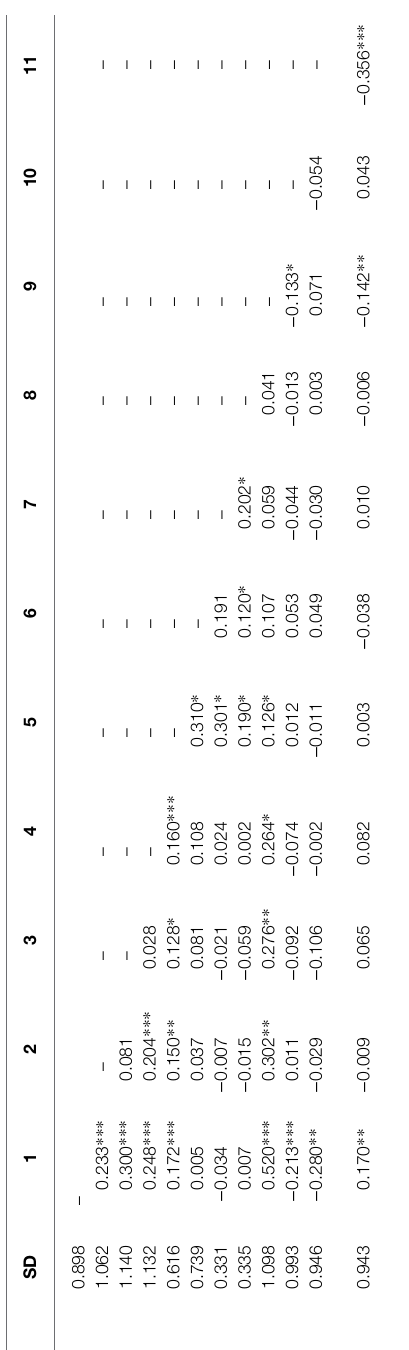
According to model 6, the regression coefficients of the interaction term between normative pressure and Individualistic identity orientation and manufacturers’ servitization strategy were negative and significant ( β = − 0.087, p < 0.01; Table 6 ). The results show that individualistic identity orientation weakens the relationship between normative pressure and manufacturers’ servitization strategy, and the hypothesis H4a is supported. According to model 7, the regression coefficient of the interaction term between mimetic pressure and individualistic identity orientation and manufacturers’ servitization strategy was negative and significant ( β = − 0.066, p < 0.05). The results show that individualistic identity orientation weakens the relationship between mimetic pressure and manufacturer’s servitization strategy, and the hypothesis H4b is supported. According to model 8, the regression coefficient of the interaction term between coercive pressure and individualistic identity oriented was negative but not significant ( β = − 0.051, p > 0.1). The results show that individualistic identity orientation does not affect the relationship between coercive pressure and manufacturer’s servitization strategy, and the hypothesis H4c is not supported. According to model 10 ( Table 7 ), the regression coefficient of the interaction term between normative pressure and relational identity oriented and manufacturers’ servitization strategy is positive but not significant ( β = 0.029, p > 0.1). The results show that relational identity orientation does not affect the relationship between normative pressure and the manufacturers’ servitization strategy, and the hypothesis H5a is not supported. According to model 11, the regression coefficient of the interaction term between mimetic pressure and relational identity orientation and manufacturers’ servitization strategy was positive and significant ( β = 0.095, p < 0.01). The results show that relational identity orientation positively moderates the relationship between mimetic pressure and the manufacturers’ servitization strategy, and the hypothesis H5b is supported. According to model 12, he regression coefficient of the interaction term between coercive pressure and relational identity orientation was positive and significant ( β = 0.095, p < 0.01). The results show that relational identity orientation positively moderates the relationship between coercive pressure and the manufacturers’ servitization strategy, and the hypothesis H5c has been verified. T A